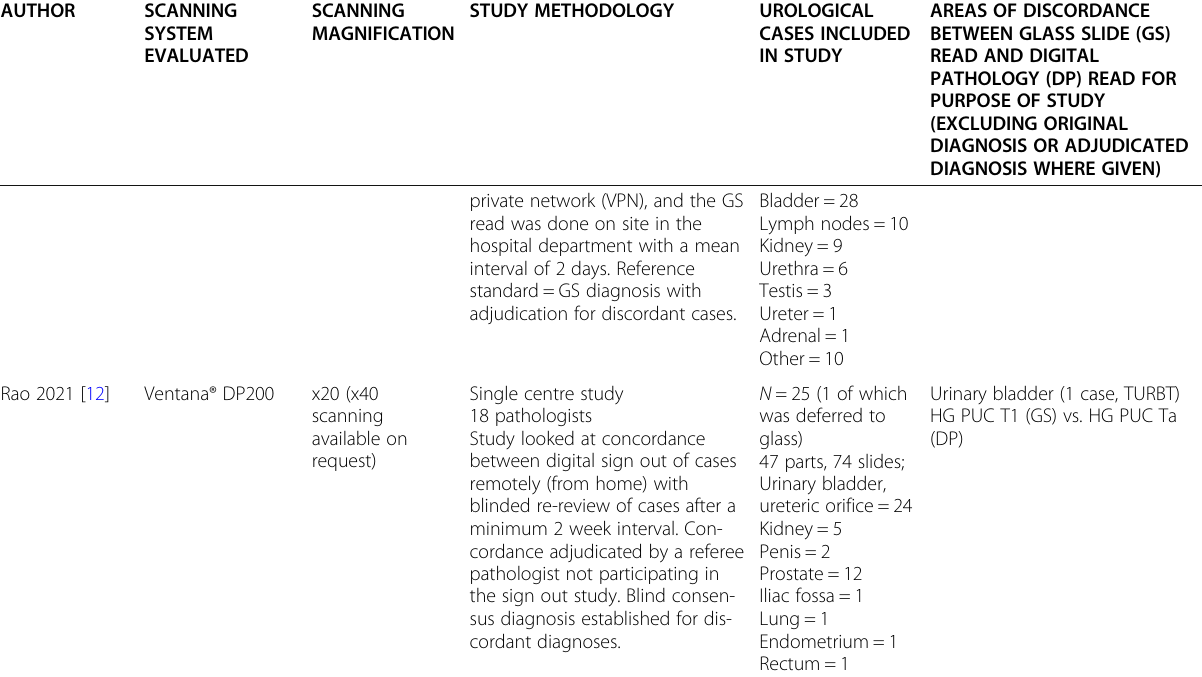
Table 2 Summary of major digital pathology validation studies which include urological specimens